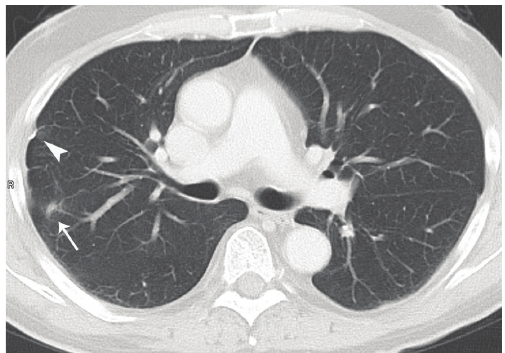
Figure 4: CT scan of the chest five months after the first application of chemotherapy. Small scar in the right upper lobe (white arrow) and small pleural calcification (white arrowhead) as residual lesions of the inflammatory